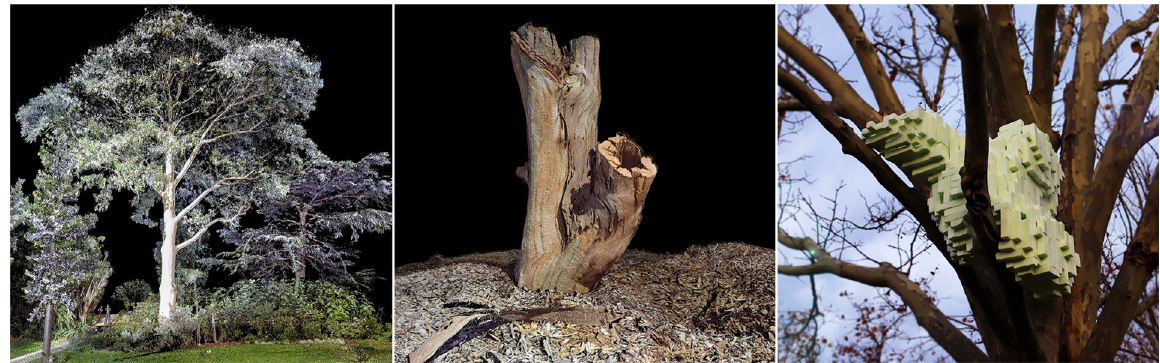
Fig. 6 Representations of hollows. Left: light detection and ranging scan of a large tree and its context. Middle: light detection and ranging scan of a hollow. Right: physical prototype of a prosthetic hollow by Dan Parker (Source: Roudavski and Parker